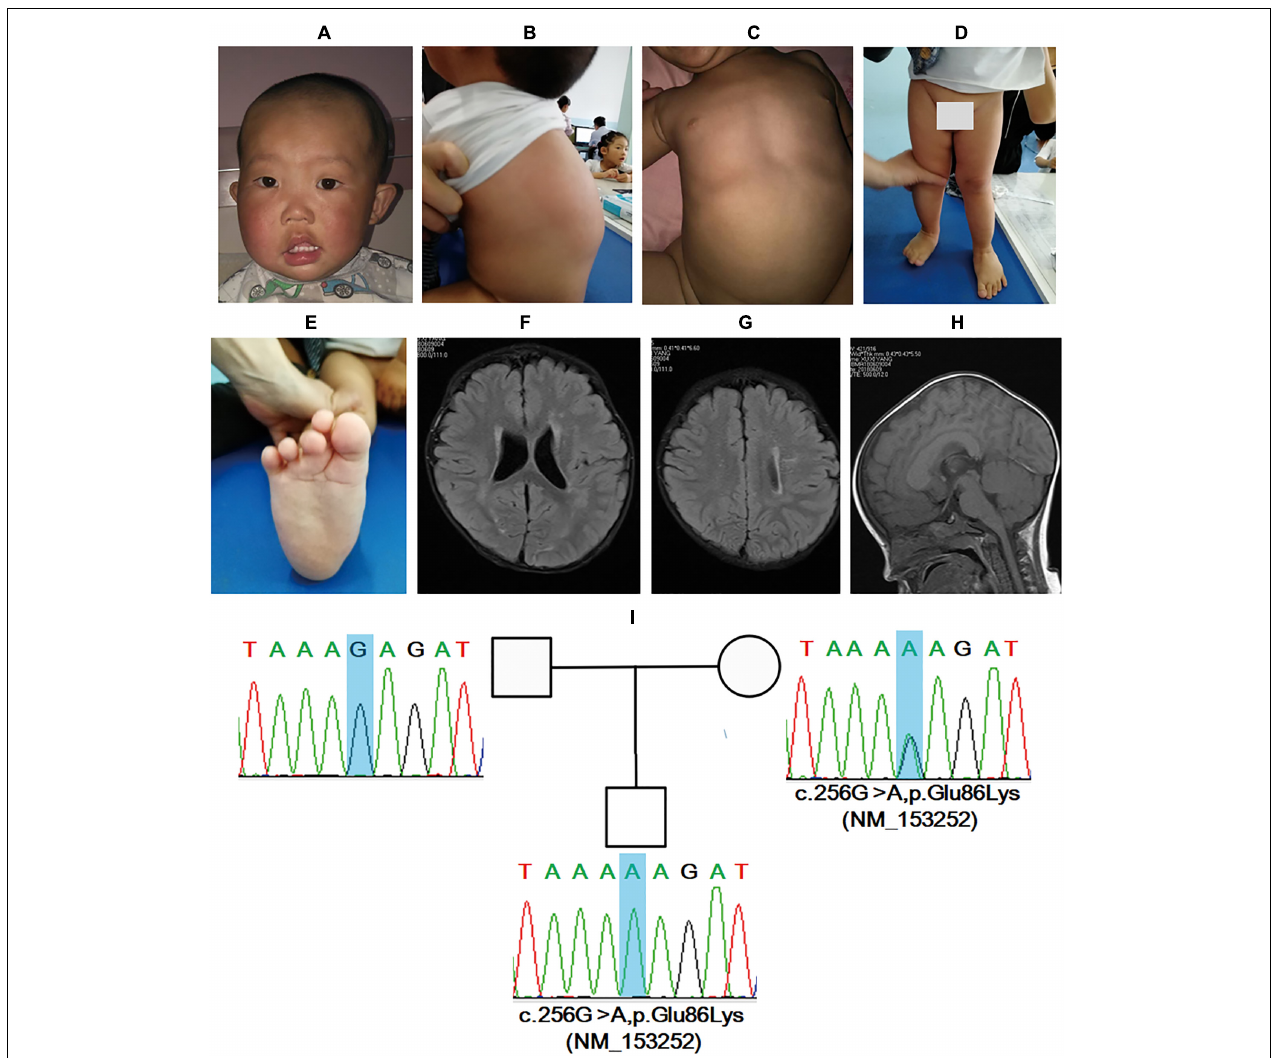
FIGURE 3 | BRWD3 variant induces mental retardation, X-linked 93 in a 1-year-and-8-month-old male patient. Facial dysmorphic features, including asymmetry, high forehead, hypertelorism, downturned corners of mouth, strabismus, drooling, and protruding ears were noted (A) . Multiple bulging masses in the back, slight pectus excavatum, lower limb asymmetry, and pes planus were revealed (B–E) . Head MRI showed abnormalities in bilateral frontal and parietal white matter together with corpus callosum (F–H) . Sanger sequencing demonstrated that the boy had a novel mutation inherited form his mother (I)